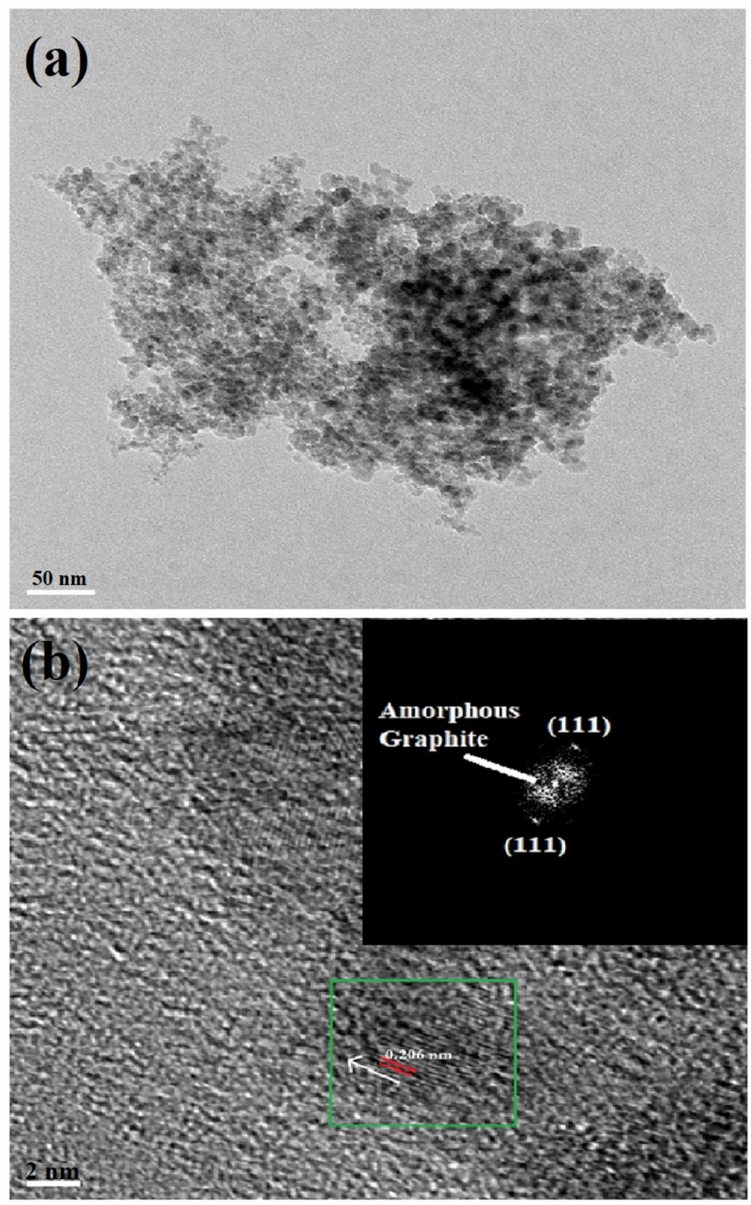
Figure 4. ( a ) HR-TEM image of NDS1 at agglomerated state shows possible small particles and ( b ) Diffraction distance 0.206 nm represents the (111) pattern of nanodiamond along with amorphous graphite